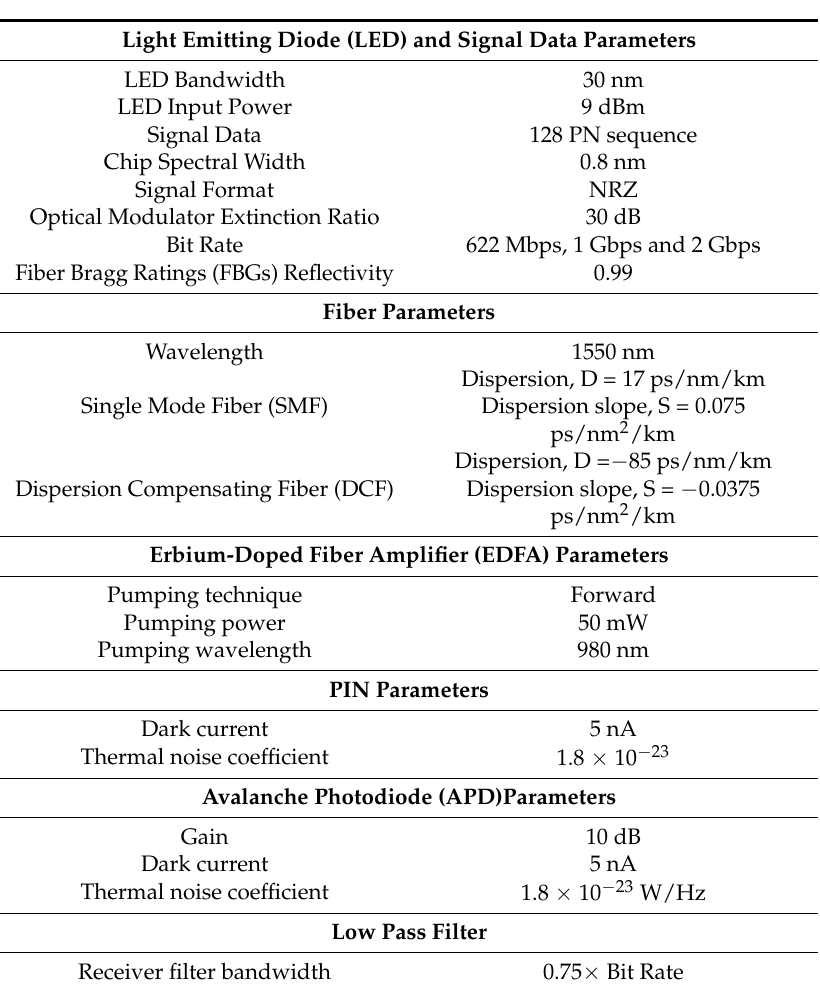
Table 3. Parameters used in